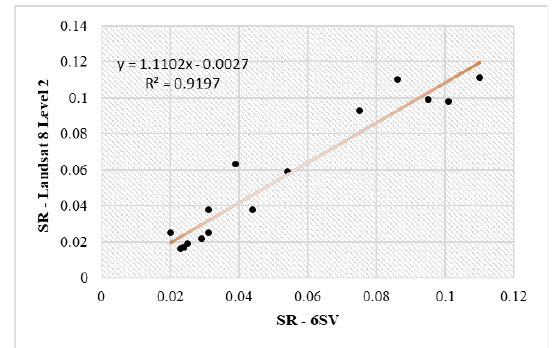
Fig. 6. Surface reflectance linear regression for OLI band